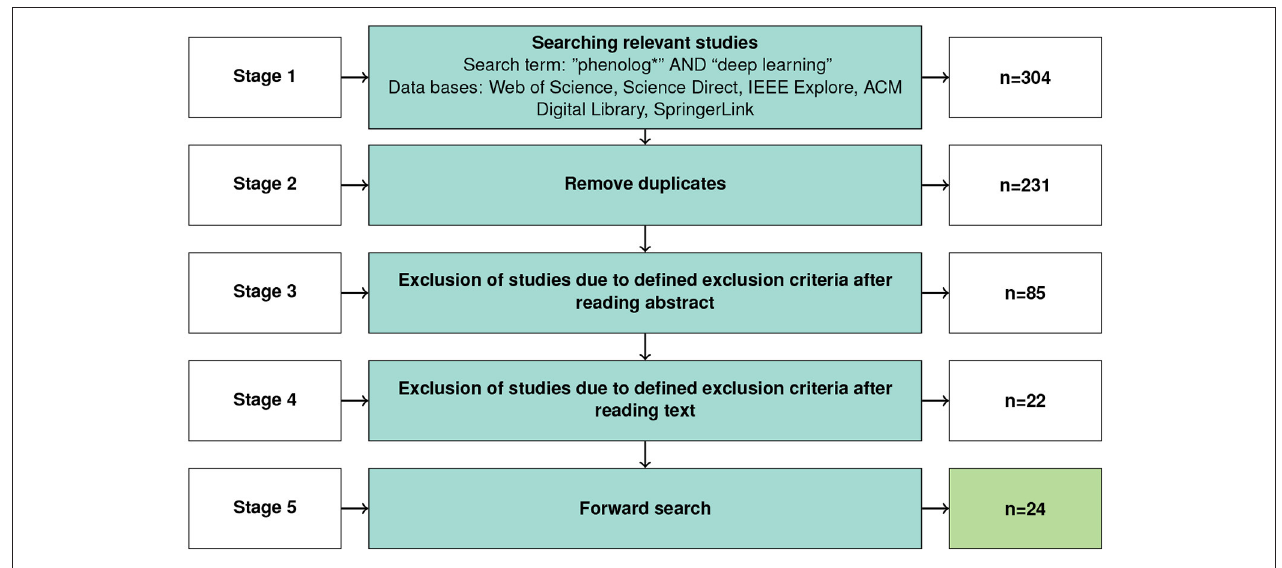
FIGURE 2 | Study selection